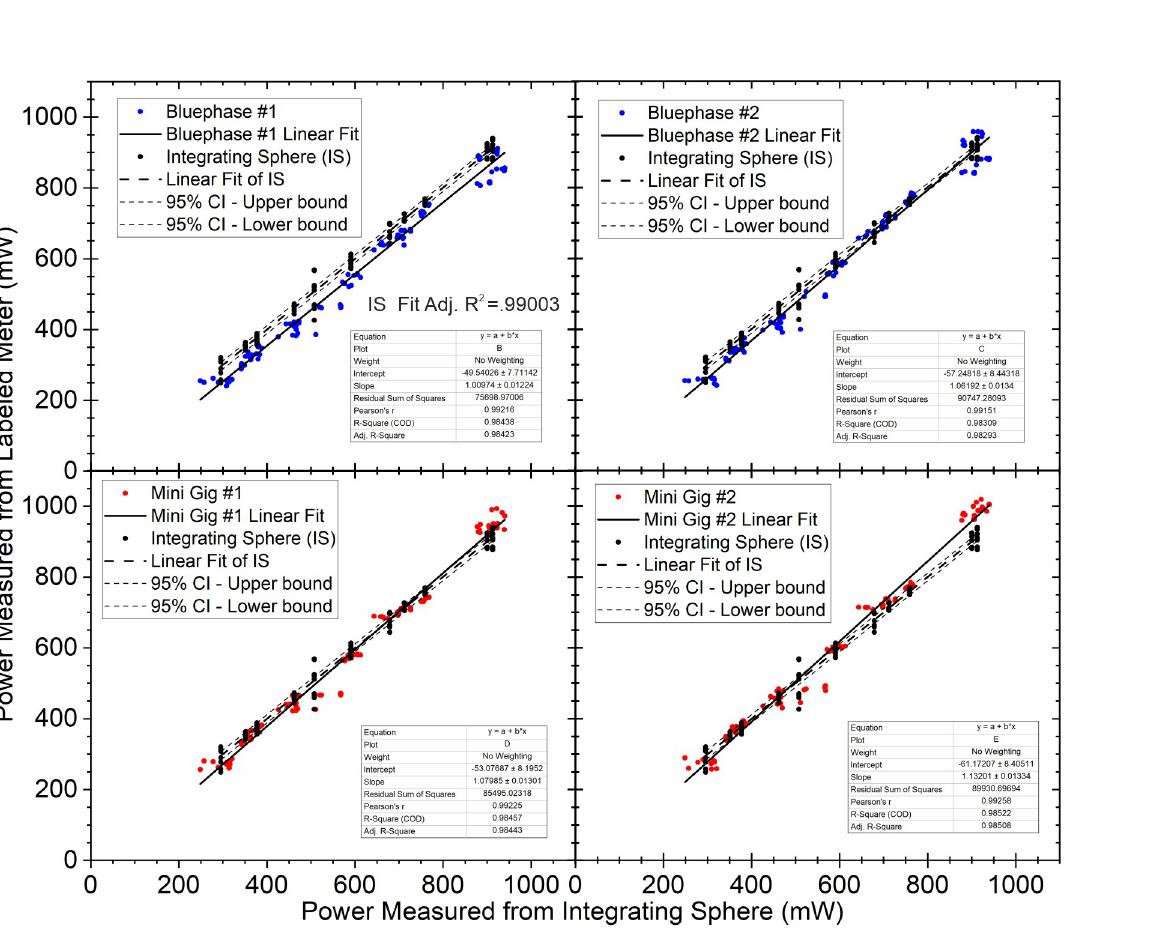
Fig 9. Regression analysis and fitted line plots with 95% confidence and prediction intervals for mean power recordings of the 24 LCUs using the two Bluephase Meters II (units #1 and #2) and the two Mini Gig spectroradiometers (units #1 and #2). The integrating sphere was the ‘gold standard (GS)’ predictor